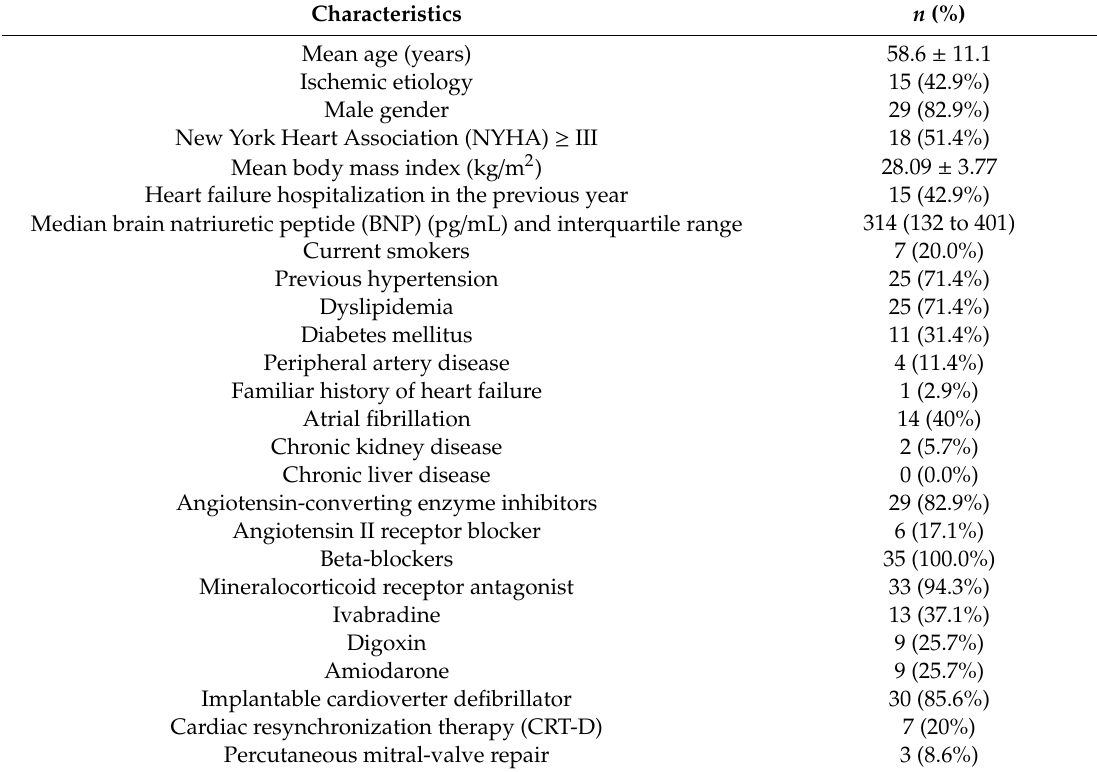
Table 1. Baseline characteristics of the study population ( n =